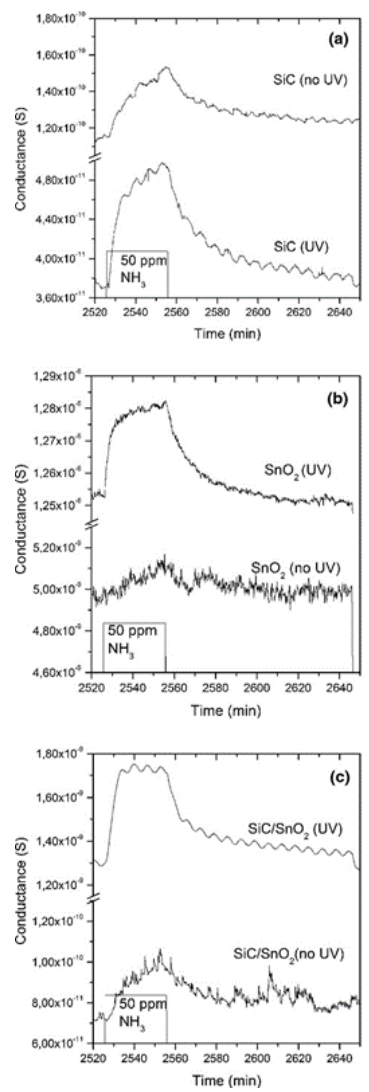
Figure 12. Dynamic responses of ( a ) pristine SiC foam, ( b ) pristine SnO 2 , and ( c ) SiC / SnO 2 to 50 ppm of NH 3 at room temperature (RT) under 30% humid airflow, with and without UV activation. Reproduced with permission [95].